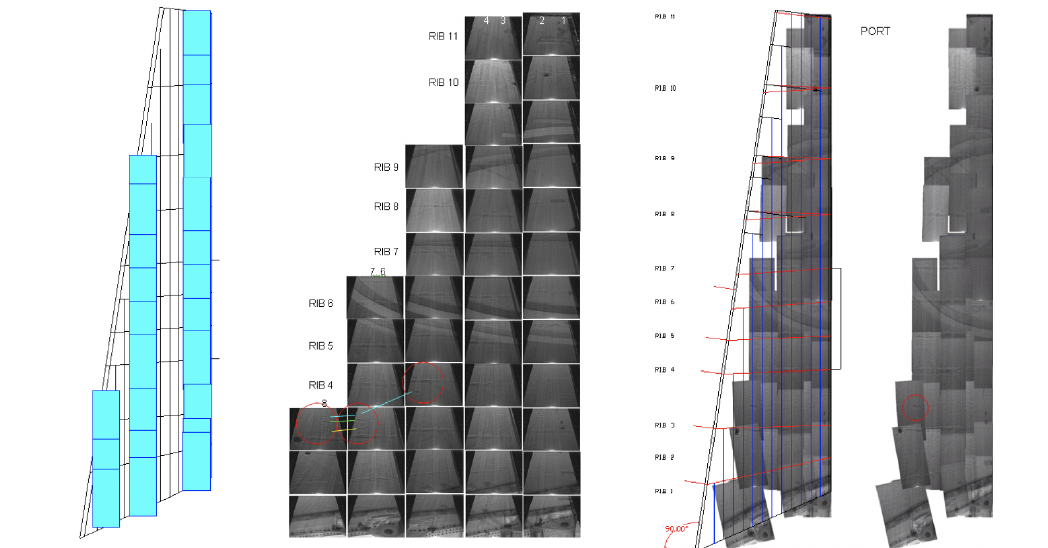
Figure 4. Wing inspection images created with DAIS 250C. Images are composed as a mosaic to cover the entire wing. Each image sample is enumerated in order to control the inspection. A specialist then perform the inspection of each